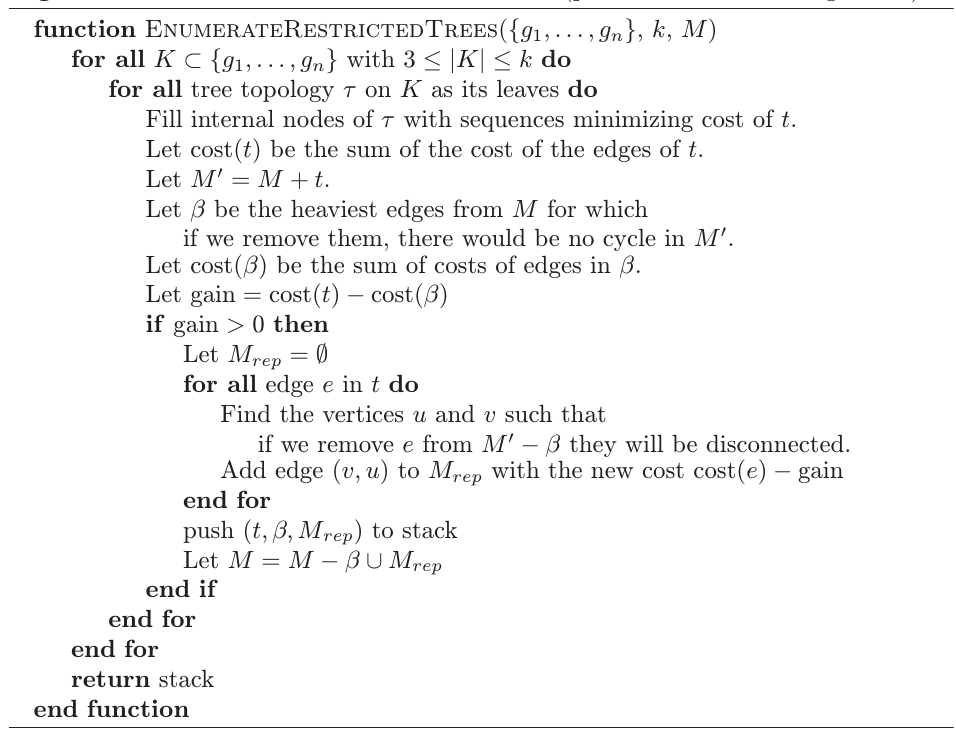
Algorithm 3 EnumerateRestrictedTrees function (part of the Scelestial